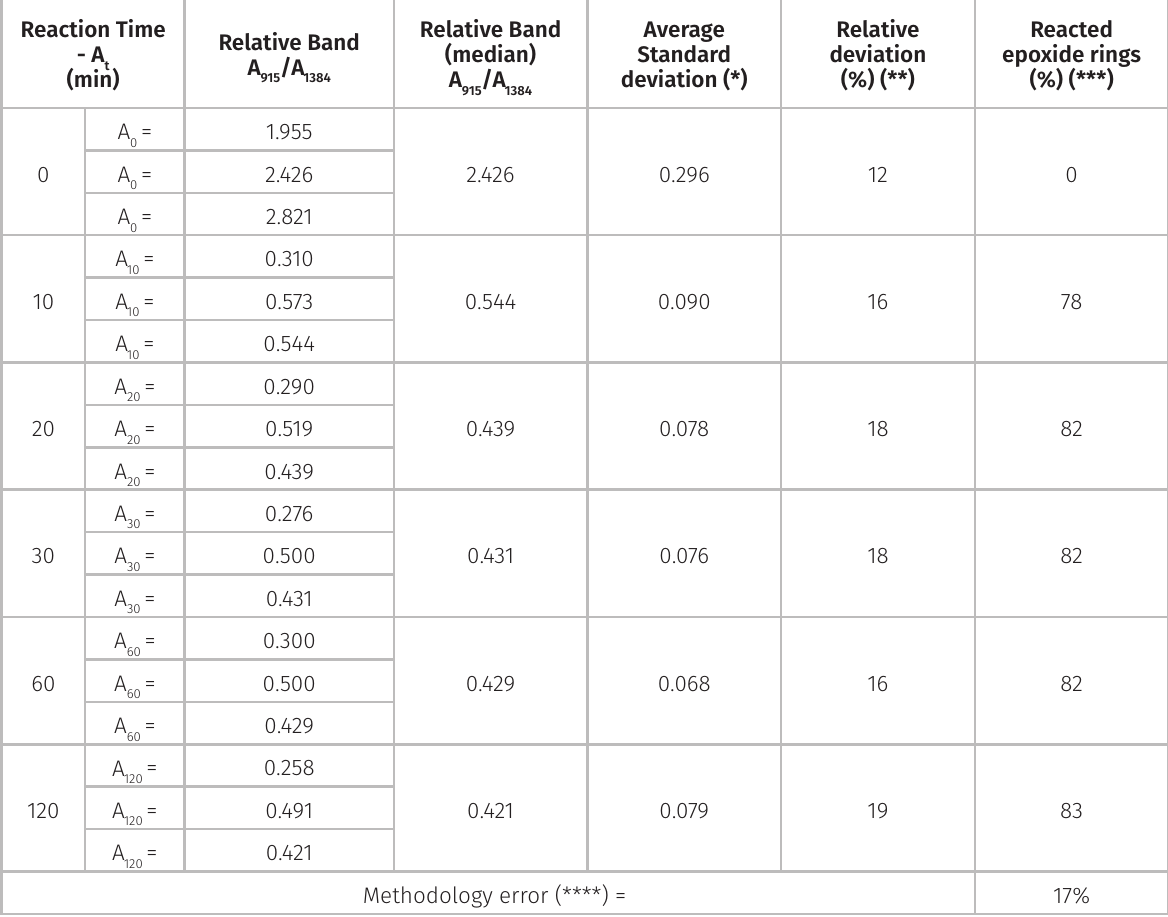
/A ) results of the EP/n-SH/DETA (5:5:1) system, reacted at 122 o C. 915 1384